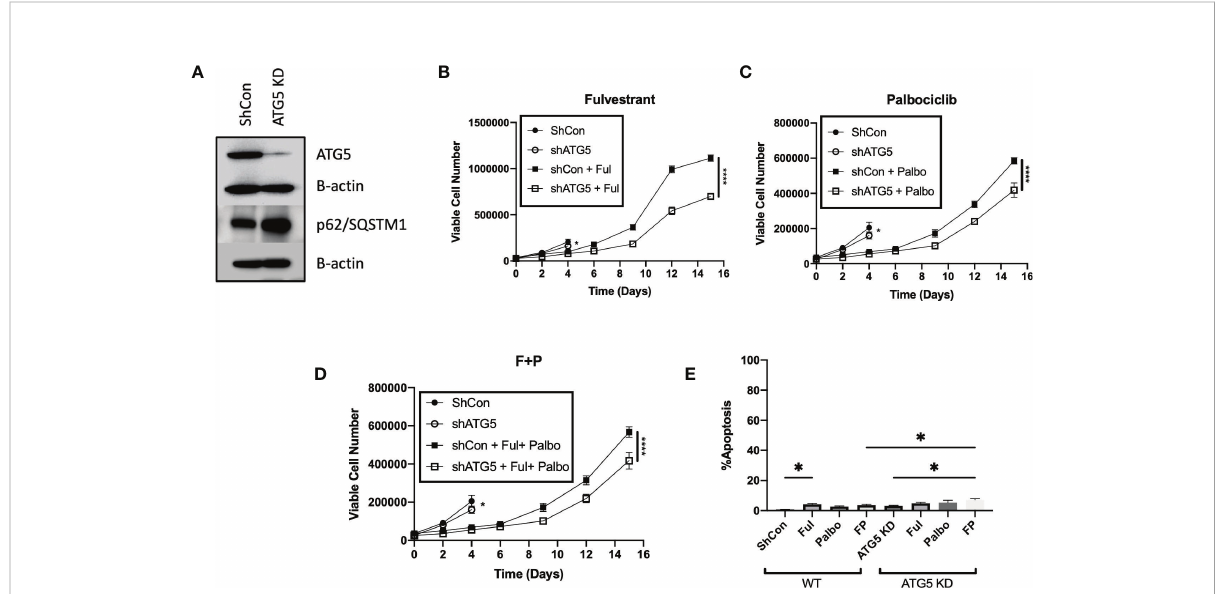
FIGURE 4 Genetic knockdown of autophagy only moderately increases sensitivity to Fulvestrant in combination with Palbociclib in MCF7 cells. Cells were treated with Fulvestrant (100 nM), Palbociclib (1 µM) or the combination for 6 days (A – E) . Short hairpin RNA was used to knockdown ATG5. (A) Western blot analysis of ATG5 and p62/SQSTM1 protein levels. (B – D) Viable cell number was counted via trypan blue exclusion on the indicated days. (E) Apoptosis was measured using annexin V/PI staining. Staining was performed on day 8 and fl uorescence was measured using fl ow cytometry. Unless stated, otherwise data were from three independent experiments. *P ≤ 0.05 and ****P ≤ 0.0001 compared to shControl cells treated with Fulvestrant, Palbociclib or the combination of Fulvestrant and